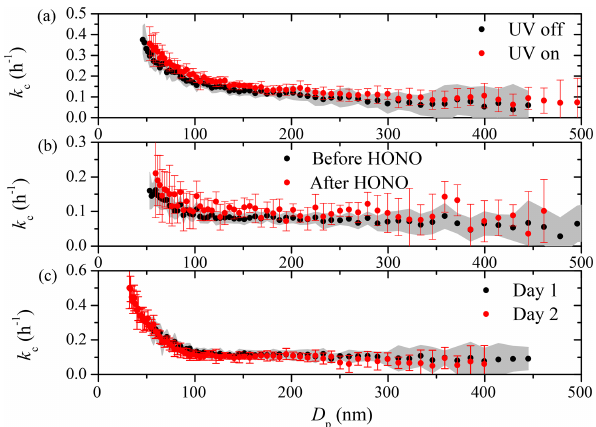
Figure 10. The coagulation-corrected particle wall-loss rate con- stant, k c , at each diameter for (a) Exp. 6, (b) Exp. 7, and (c) Exp. 8 and 9. The uncertainties associated with the corresponding k c (D p ) values are either expressed as the grey area or the red error